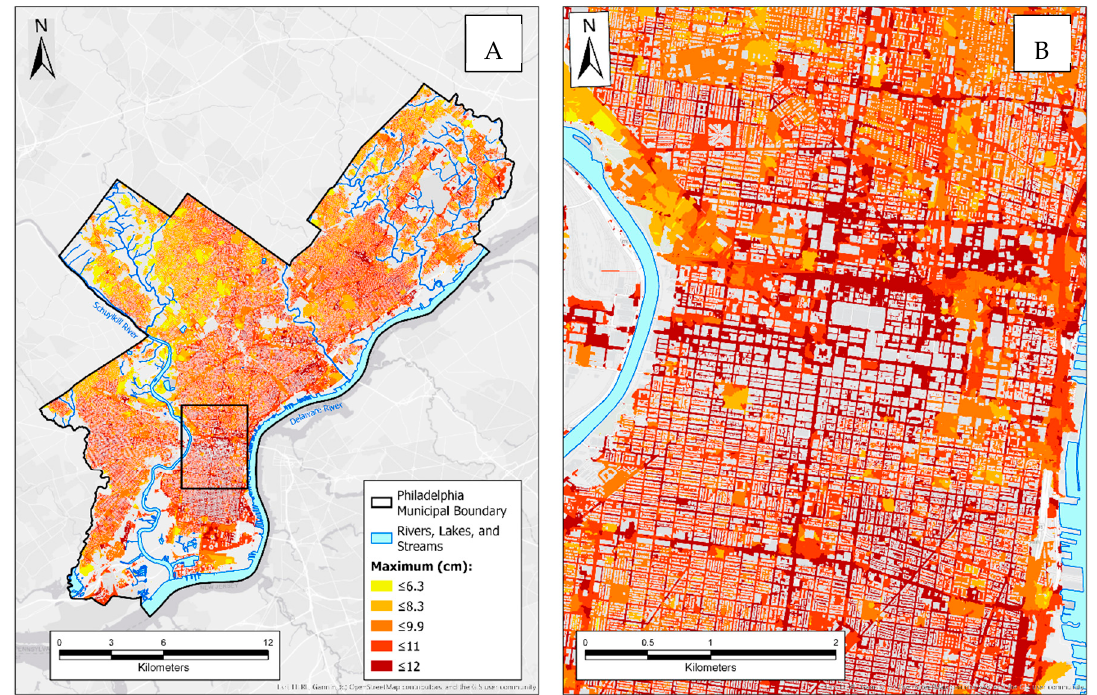
Figure 7. Maximum estimated runoff depths for each subbasin, estimated by the NRCS or rational models for a 24-hour, 10-year storm for city of Philadelphia ( A ) and Center City ( B ).